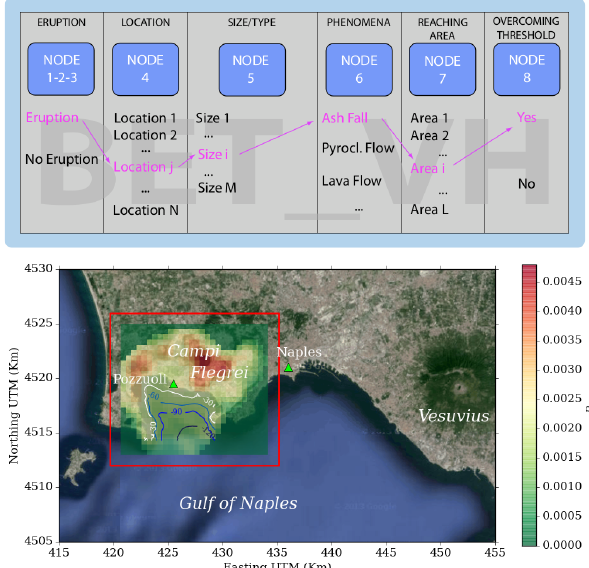
Figure 1. General event tree scheme for BET_VH after Marzocchi et al. (2010) (upper panel). Campi Flegrei caldera (red rectangle) and vent opening probability map of the 700 vents after Selva et al. (2012b) (bottom panel). Isobaths at 30, 60, 90 and 120 m depth in the Gulf of Pozzuoli are shown (contour lines from white to dark blue)